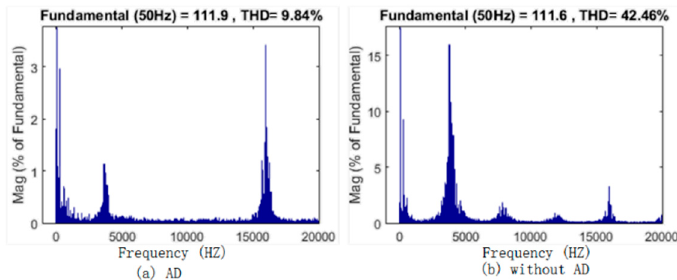
Figure 19. Harmonics comparison of i L between AD and without AD at 60A i L .